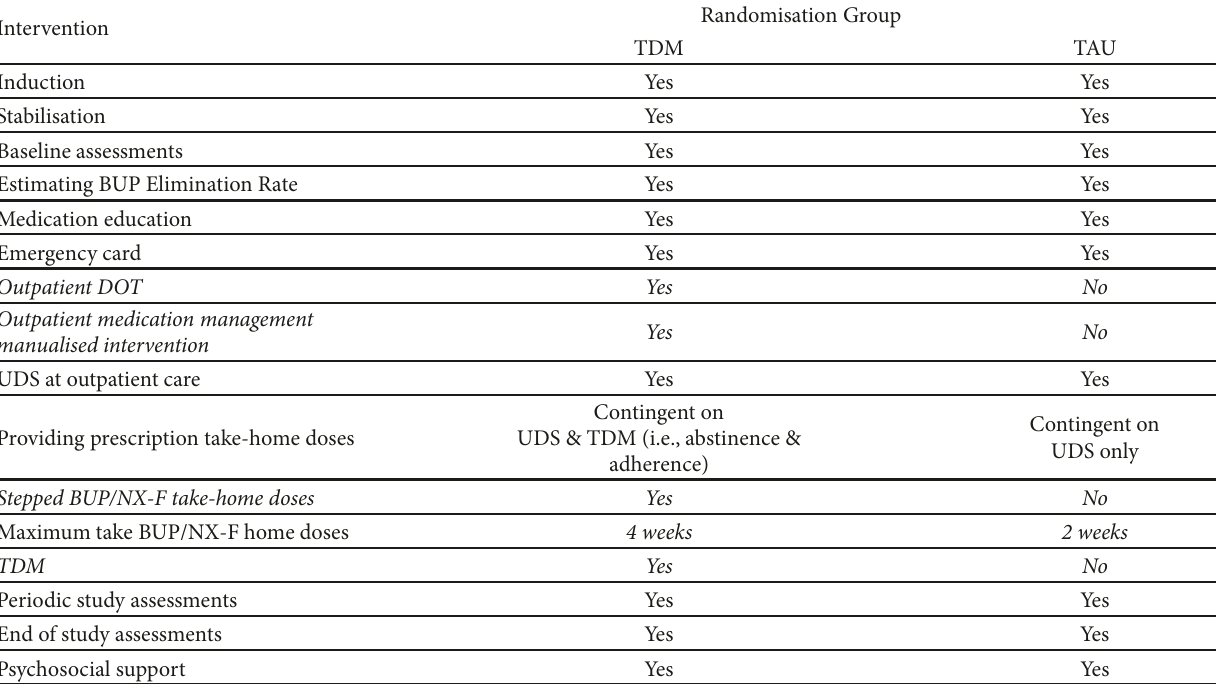
Table 3: Interventions under study groups (TDM;